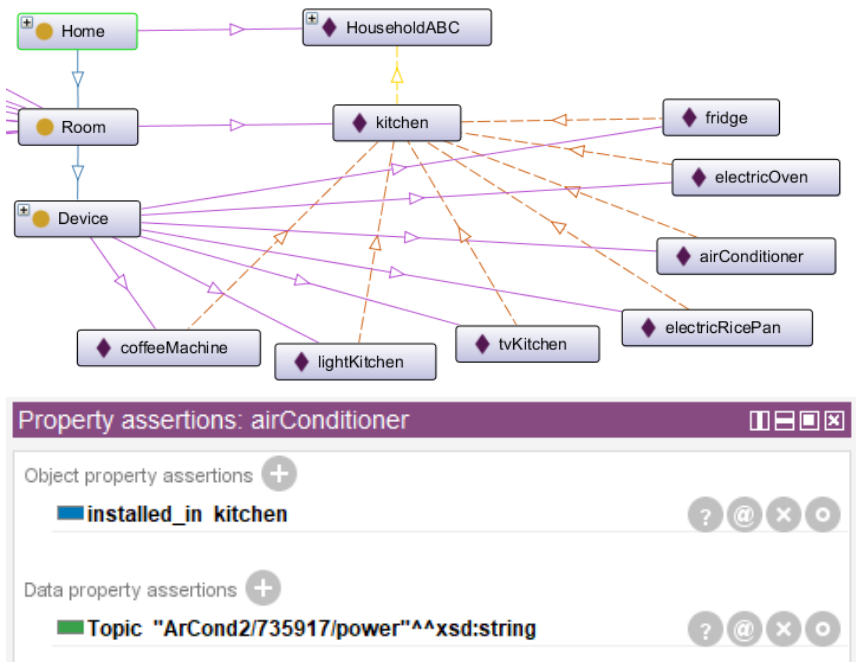
Figure 17. Kitchen perspective in digital twin smart home ontology.